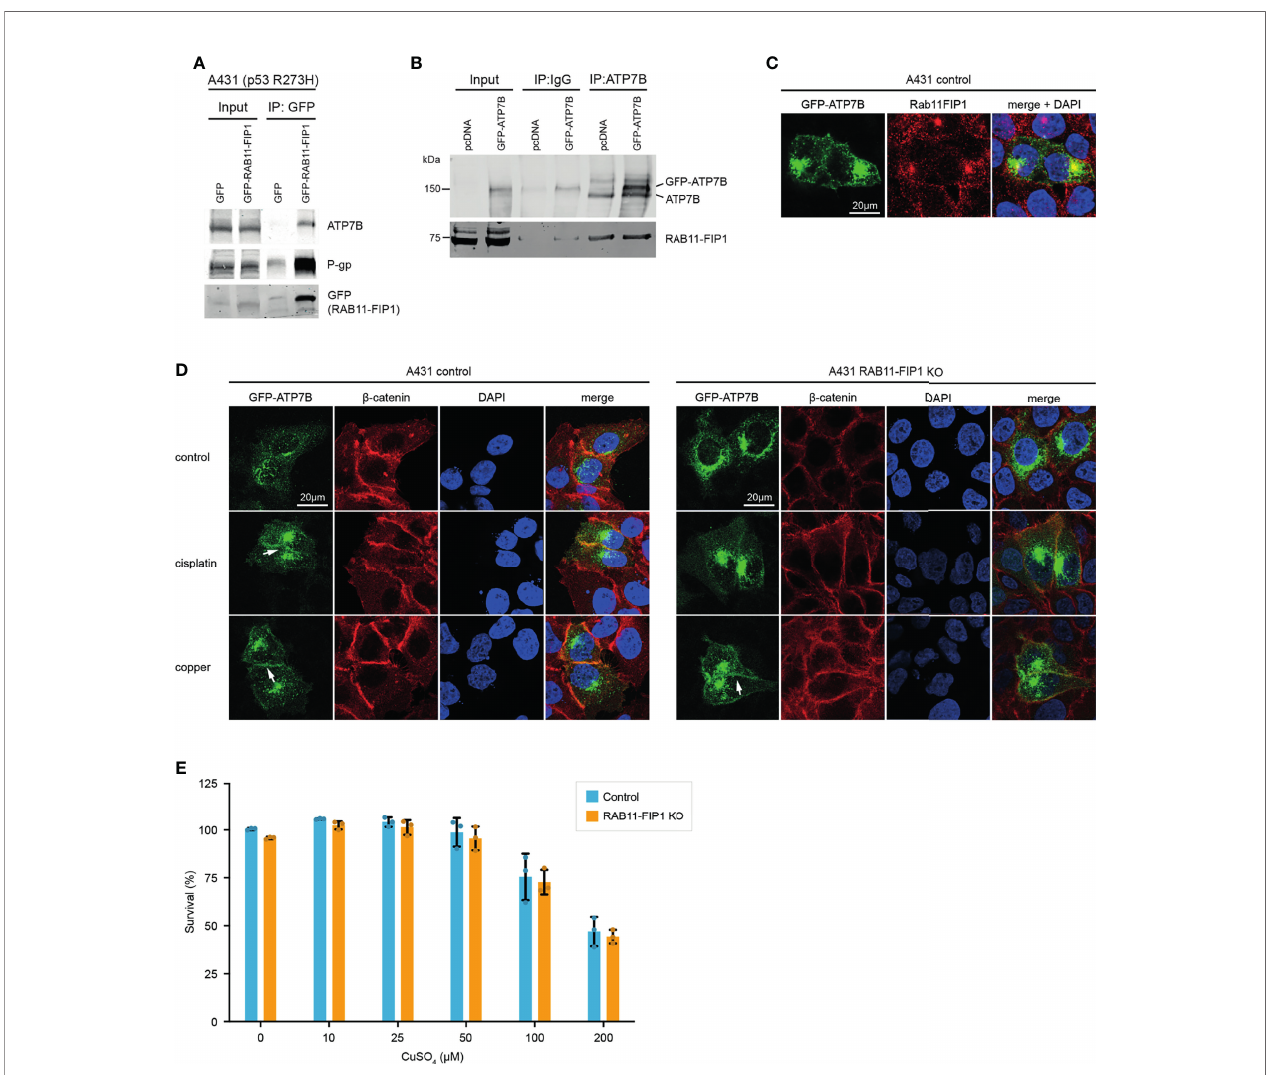
FIGURE 2 | Mutant p53 promotes ATP7B plasma membrane expression in a Rab11-FIP1 dependent manner upon cisplatin stimulation. (A) A431 cells expressing mutant p53 (R273H) were transfected to express GFP or GFP-Rab11-FIP1. GFP was immunoprecipitated and co-immunoprecipitation was assessed through western blot, using an ATP7B antibody. (B) Co-immunoprecipitation of endogenous ATP7B with Rab11-FIP1 in mutant p53 A431 cells expressing GFP-ATP7B or a GFP control. ATP7B was immunoprecipitated followed by western blot to detect Rab11-FIP1 binding. (C) Co-localisation of endogenous Rab11-FIP1 and GFP-ATP7B (GFP) was determined using immuno fl uorescence in A431 cells transfected with GFP-ATP7B (D) A431 control or A431 Rab11-FIP1-KO cells transfected with GFP-ATP7B were incubated in cisplatin (3µM) or copper (CuSO 4 , 100µM) for 2 h and assessed for ATP7B localisation. b -catenin was used as membrane marker and DAPI as nuclear marker. Arrows indicate ATP7B plasma membrane expression. All immuno fl uorescence experiments were performed in triplicates and assessed in >25 cells per experiment and observer with single plane confocal imaging. Representative images are shown. (E) A431 control or A431 Rab11-FIP1-KO cells were incubated in increasing copper concentrations for 72 h and subjected to a resazurin survival assay. Error bars indicate standard deviation of 3 independent experiments (n=3). No statistical signi fi cance was observed (unpaired t-test) in copper-treated cells. Materials and methods are provided in Supplemental Data 1